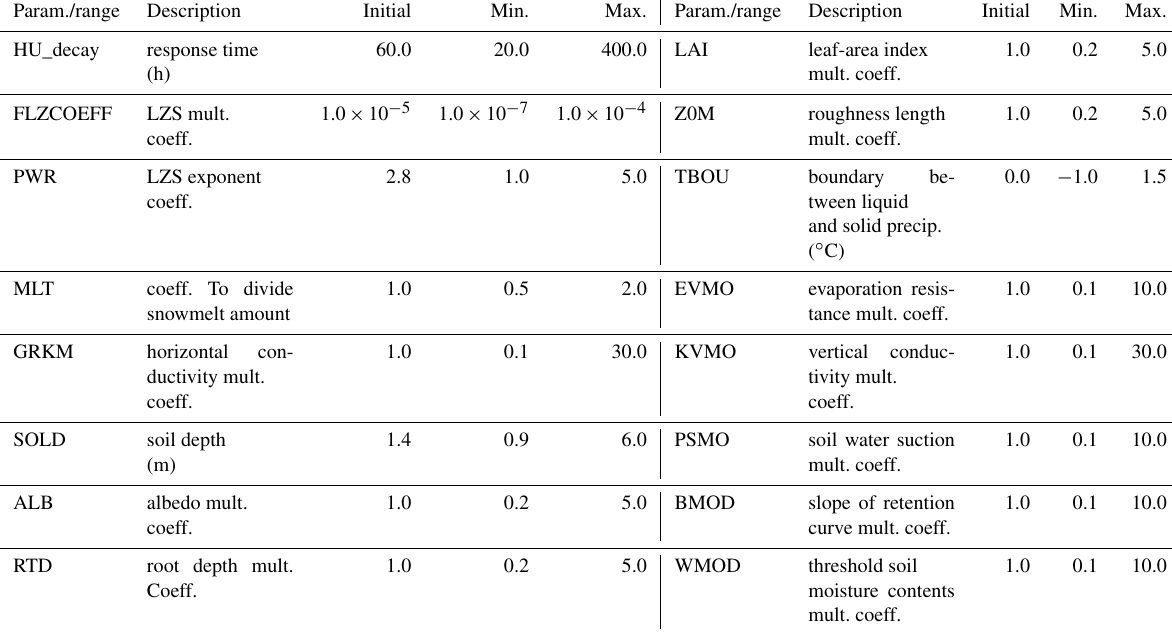
Table 2. Information on GEM-Hydro-UH 16 free parameters; LZS: lower zone storage; coeff.: coefficient; mult.: multiplicative; precip.: precipitation; param.: parameter; min.: minimum; max.: maximum. Param./range